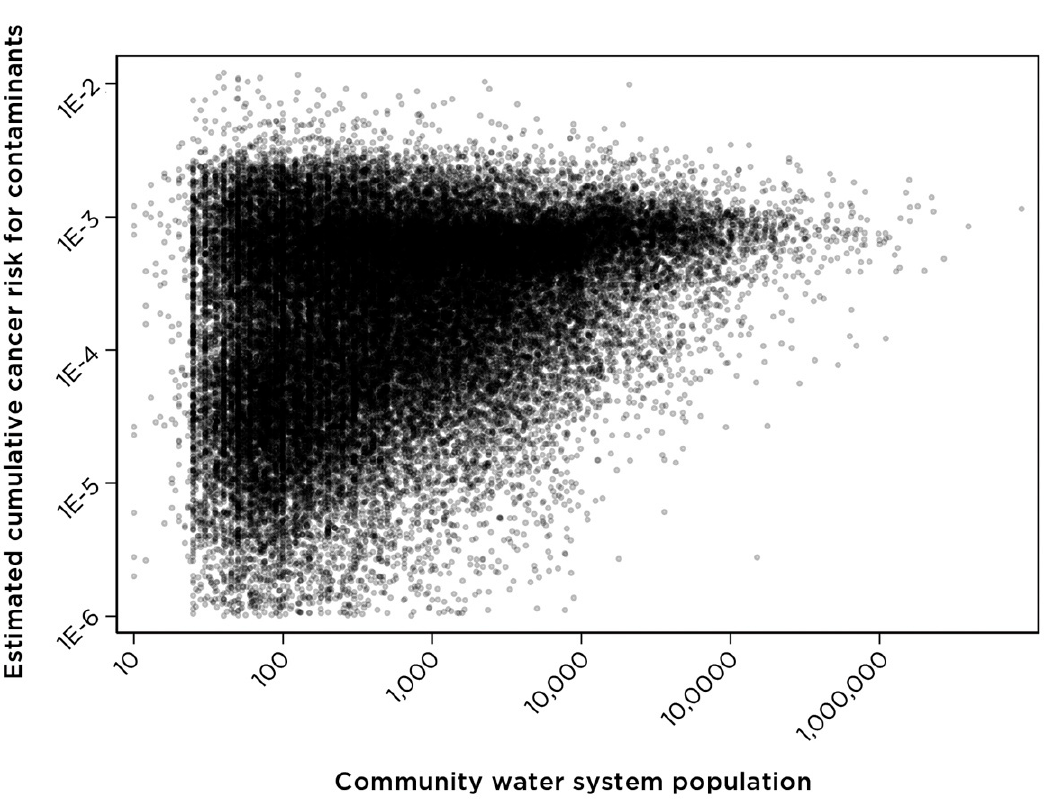
Figure 2. Estimated cumulative cancer risk for community water systems of different sizes. Information on the population served by community water systems was obtained from the U.S. EPA Envirofacts database.